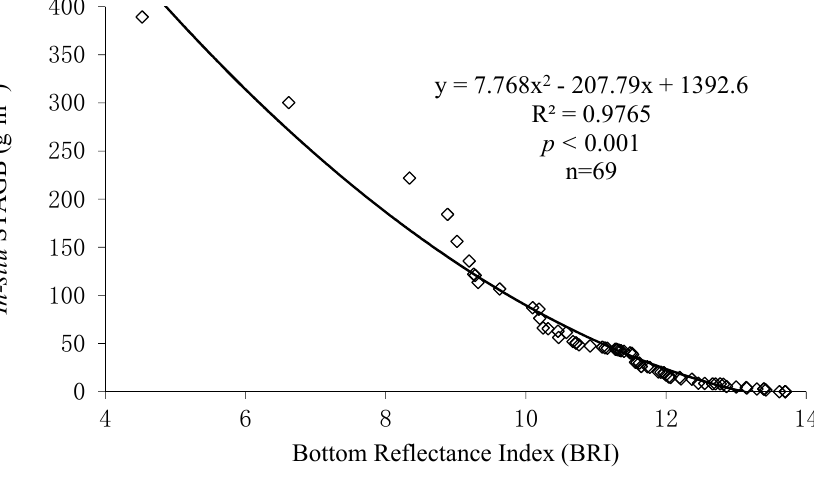
Figure A3. The relationship between BRI b of Landsat 5 TM and in situ STAGB.